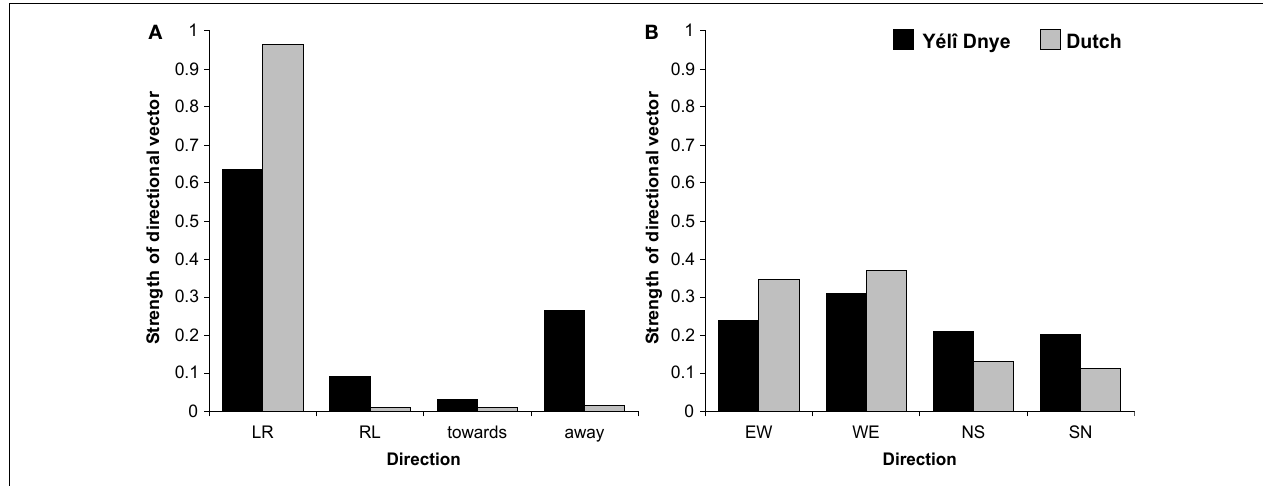
FIGURE 9 | Placement of non-verbal temporal sequences. (A) Shows the proportion of left-to-right (LR), right-to-left (RL), toward-the-body, or away-from- the-body responses. (B) Shows the proportion of responses across participants that used an east-to-west (EW), west-to-east (WE), north-to-south (NS), or south-to-north (SN) strategy.